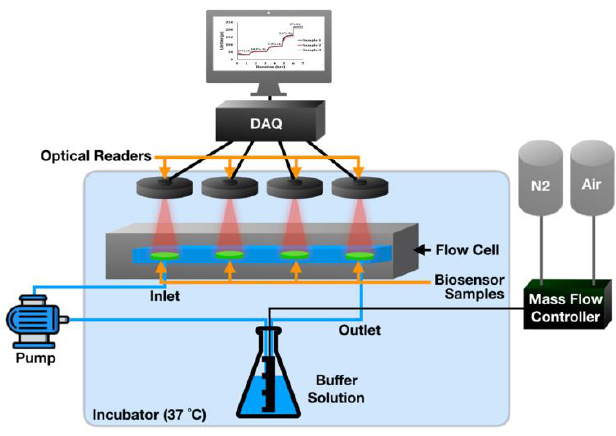
Figure 1. Schematic of flow-through system for in vitro biosensor assessments of oxygen response.